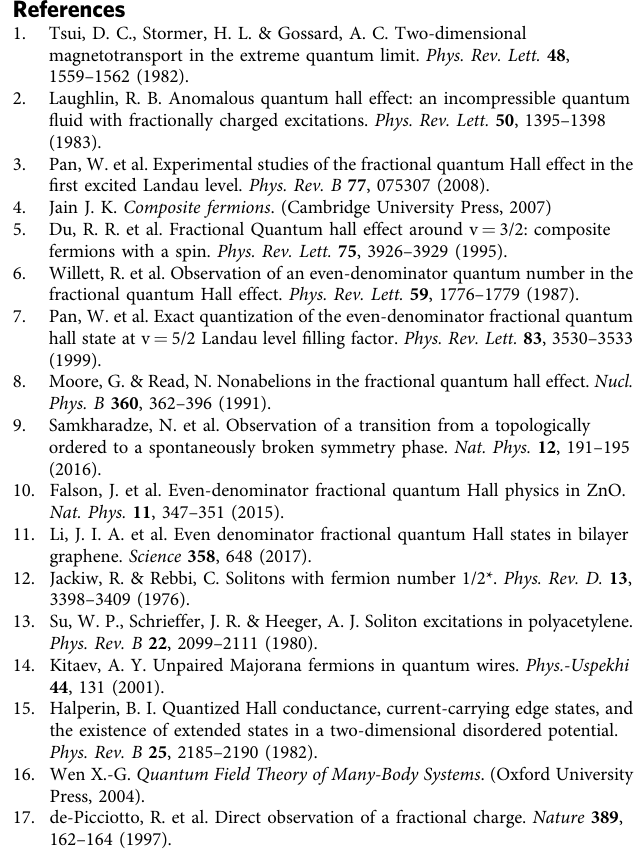
e 2 h , and the dashed 2 e 2 h . Source data are 6